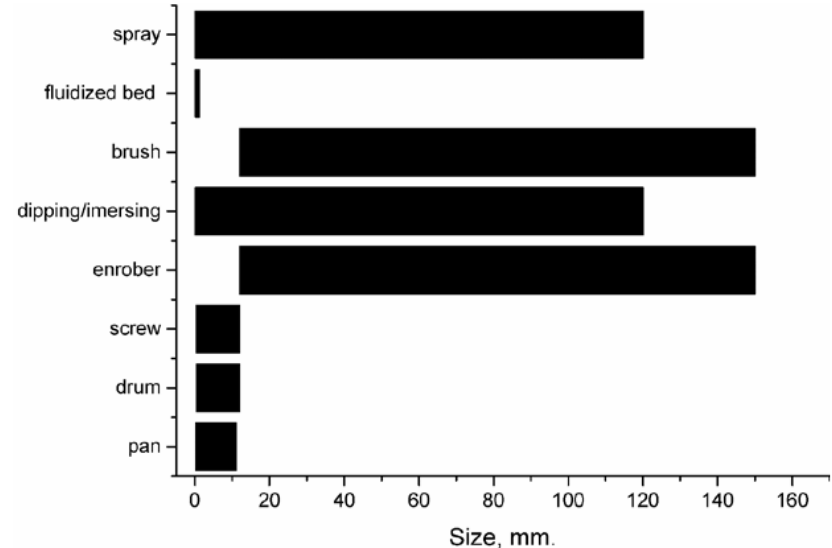
Figure 11. Influence of material size on coating selection techniques.